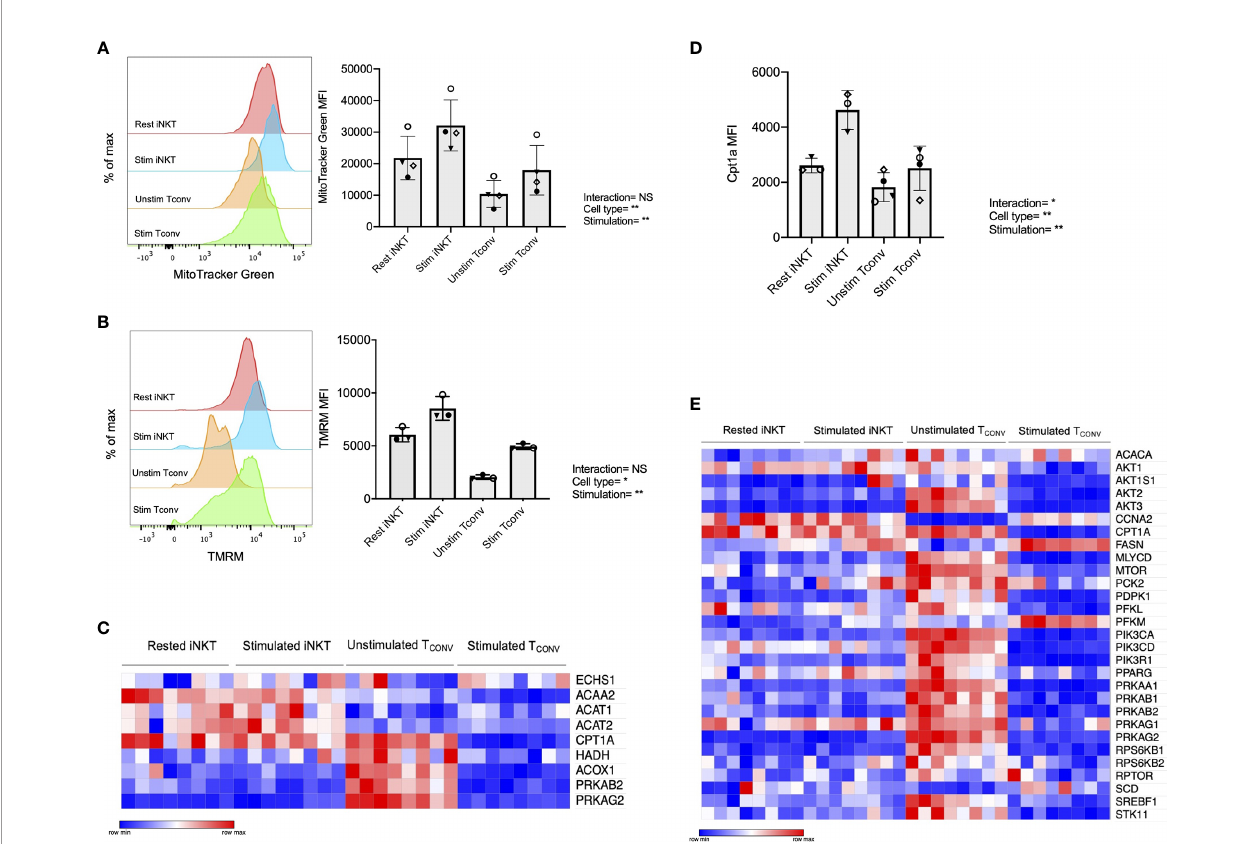
FIGURE 4 | Human iNKT cells possess enhanced mitochondrial metabolism and FAO relative to T CONV . (A) Histograms (left) displaying mean fl uorescence intensity (MFI) of MitoTracker Green emission (FITC channel) in puri fi ed rested and stimulated iNKT cells and T CONV from n=3 matching human donor biological replicates run in independent experiments (Right) Bar graphs of MFIs. Symbols represent independent, matched human donors. (B) Histograms (left) displaying mean fl uorescence intensity (MFI) of TMRM emission (PE channel) in puri fi ed rested and stimulated iNKT cells and T CONV from n=3 matching human donor biological replicates run in independent experiments. (Right) Bar graphs of MFIs. Symbols represent independent, matched human donors. (C) Heatmap of n=8 independent biological replicates of matched healthy human donor rested and stimulated iNKT cells and T CONV (processed per schematic in Supplementary Figure 1 ) relative expression of fatty acid oxidation (FAO) pathway genes in NanoString nCounter Human Metabolic Pathways probe set. Genes with counts under 100 were eliminated from analysis. Coloring indicates relative expression of each gene, from low (blue) to high (red). Heatmap generated on Morpheus. (D) Puri fi ed rested and stimulated human iNKT cells and T CONV were stained for intracellular Cpt1a expression after 48 hours. Mean fl uorescence intensity (MFI) of Cpt1a (left) and percentage of Cpt1a positive cells (right) for each cell type relative to isotype control indicated. Each symbol represents matched healthy human donor sample; each biological replicate set of cells was run in independent experiments. (E) Heatmap of n=8 independent biological replicates of matched healthy human donor rested and stimulated iNKT and T CONV relative expression of AMPK pathway genes in NanoString nCounter Human Metabolic Pathways probe set analyzed as in (C) . For studies comparing mean fl uorescence intensity values (A, B, D) , statistical signi fi cance between groups (NS, non-signi fi cant; *p < 0.05, **p < 0.01) was determined by two-way ANOVA tests and indicated on the bottom of each graph. For NanoString data in (C, E) , each set of matched donor biological replicates was independently collected, stimulated, and harvested for mRNA and all samples were run and analyzed on NanoString